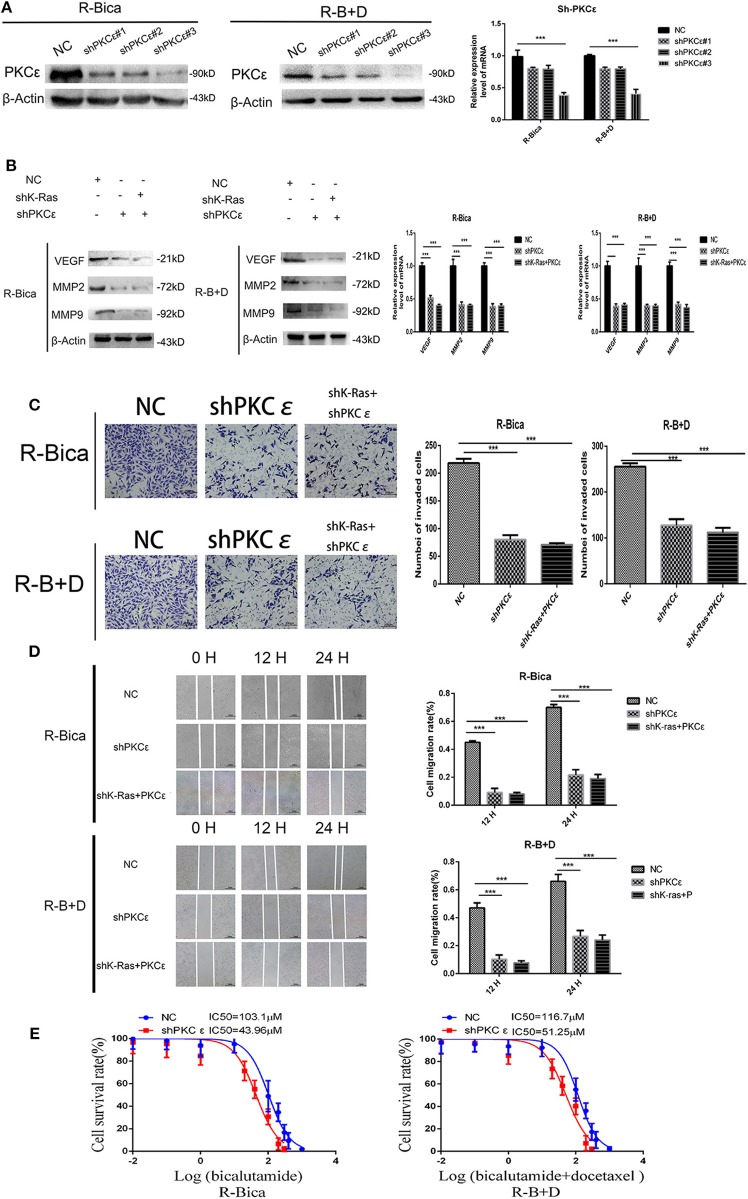
K-Ras regulates protein and mRNA factors of invasion and migration via PKCε. (A) CRPC cells were infected with sh lentiviral PKCε; Western blotting and qPCR analyzed the expression of PKCε. (B)The expression of VEGF, MMP2, and MMP9 in CRPC cells was detected by Western blot and qPCR. (C,D) The R-Bica and R-B+D cell metastasis capacities were assessed by the method of Transwell and wound-healing assays. (E) The IC50 of R-Bica and R-B+D cells following treatments with LV-shPKCε and LV-NC was analyzed by CCK-8 assay. Cells were infected with a negative control or shPKCε or shK-Ras+PKCε. NC, negative control for Lentivirus-shK-Ras and Lentivirus-shPKCε; sh, small hairpin; shK-Ras, K-Ras knockdown; shPKCε, PKCε knockdown. ***P < 0.001.